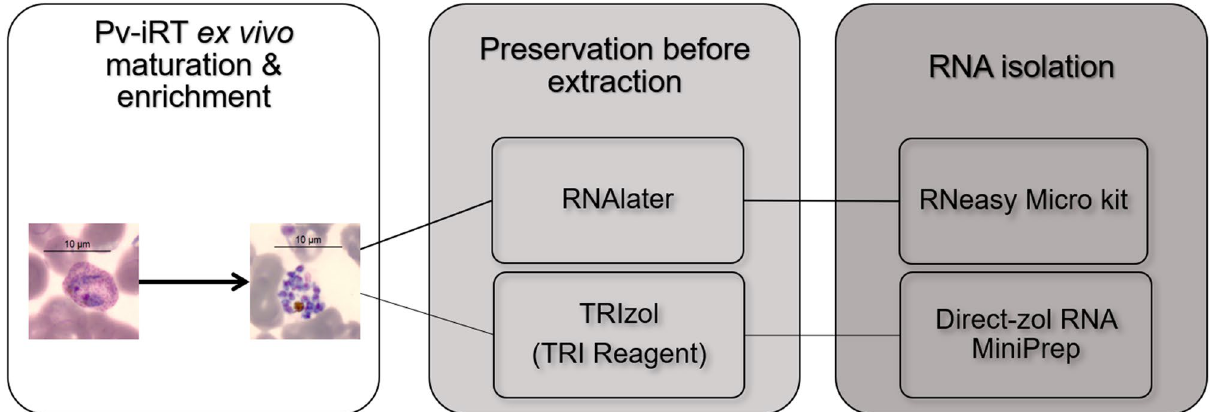
Figure 1. P. vivax isolation, short-term ex vivo maturation, enrichment and total RNA extraction. Blood samples were immediately processed. White blood cells were depleted by CF11 filtration 25 . The early blood staged parasites were short-term cultured ex vivo to allow maturation followed by Percoll gradient enrichment 23 . Total number of Pv-iRTs was accessed before preservation in RNAlater or TRI Reagent at − 80 °C. RNA extraction was executed using the RNeasy Micro